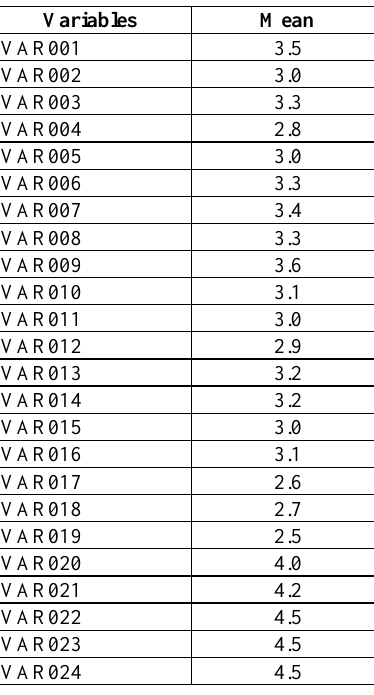
Table 3. Descriptive statistic